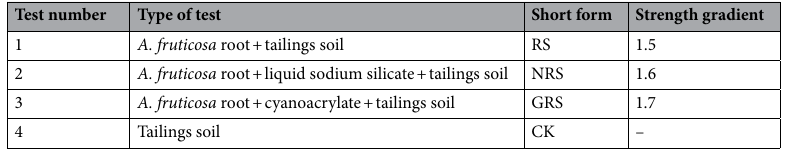
Table 2. Test sample